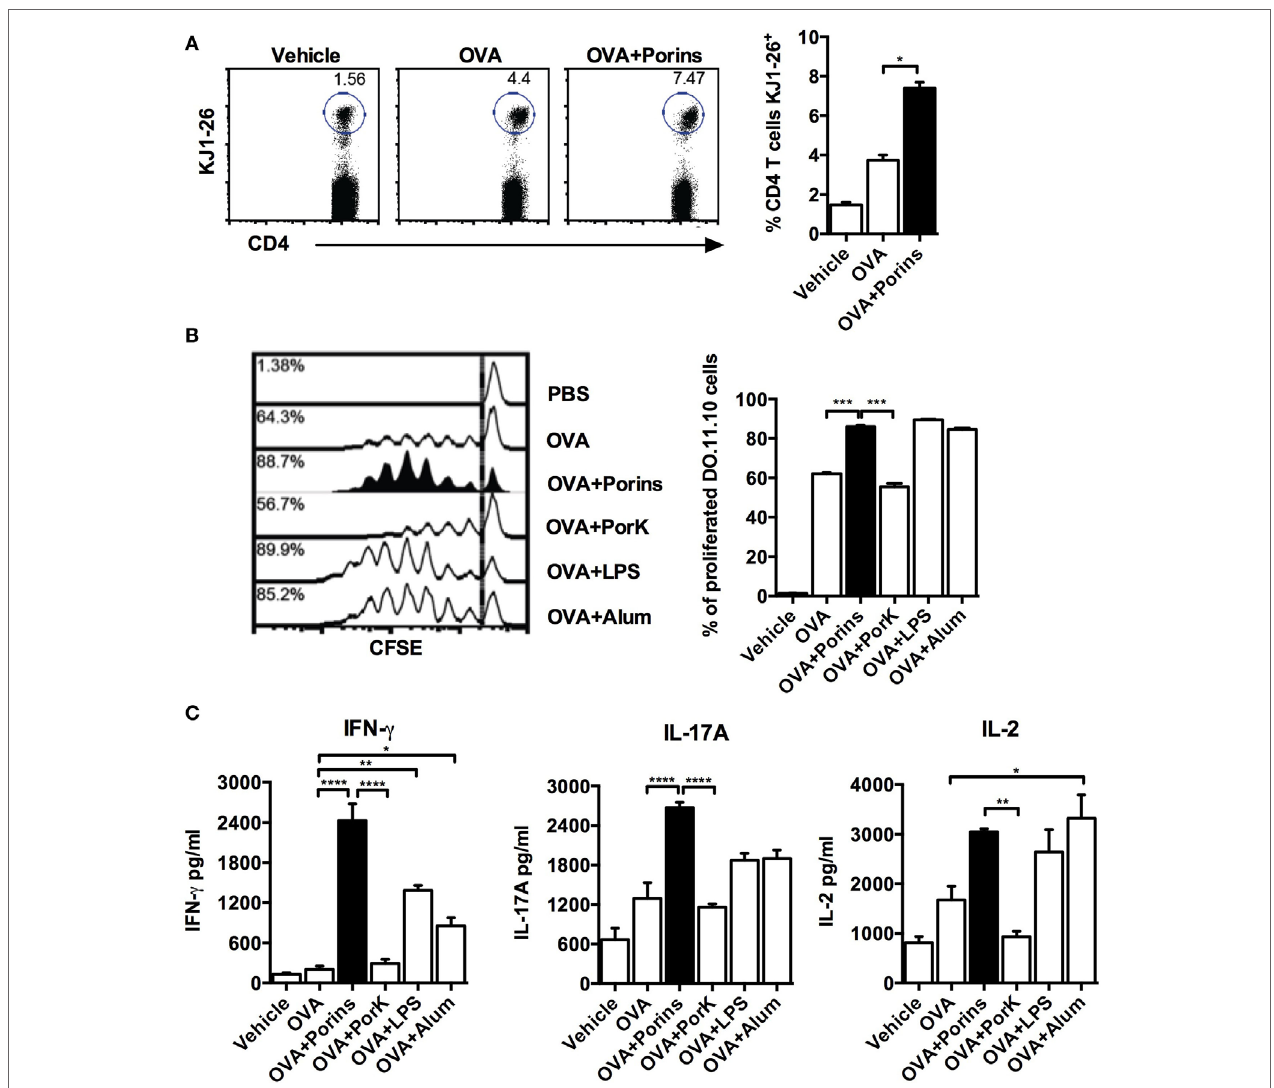
FigUre 2 | Porins from S. Typhi increase cell proliferation and Th1/Th17 cytokine production by ovalbumin (OVa)-specific cD4 + T cells . A total of 5 × 10 6 CFSE-labeled CD4 + T cells from DO.11.10 mice were transferred to naïve BALB/c mice (4 mice per group) 24 h prior to s.c. injection into the front footpads with 100 μ g of OVA, OVA + 10 μ g of porins, OVA + 10 μ g of PorK, OVA + 5 μ g of LPS, or OVA + 100 μ g of alum. Three days later, in vivo proliferation was assessed as frequency of OVA-specific cells (K1-J26 + cells) (a) and CFSE dilution (B) . (c) Coculture of purified CD4 + T cells from immunized DO.11.10 BALB/c chimeras with OVA-pulsed dendritic cells was performed, supernatants were collected 24 h later, and cytokines were measured by CBA assay. Mean + SEM are shown. These data are representative of three independent experiments. Statistical analysis was performed using one-way ANOVA with Bonferroni test post hoc . Statistical differences are depicted as * P < 0.05, ** P < 0.01, *** P <